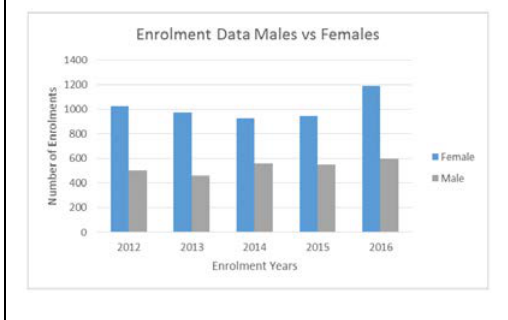
Figure 1: STEPS enrolments 2012-2016